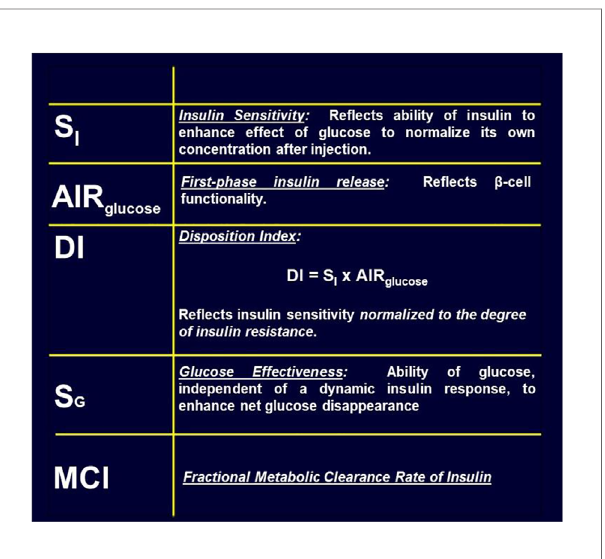
FIGURE 15 | Factors contributing to glucose